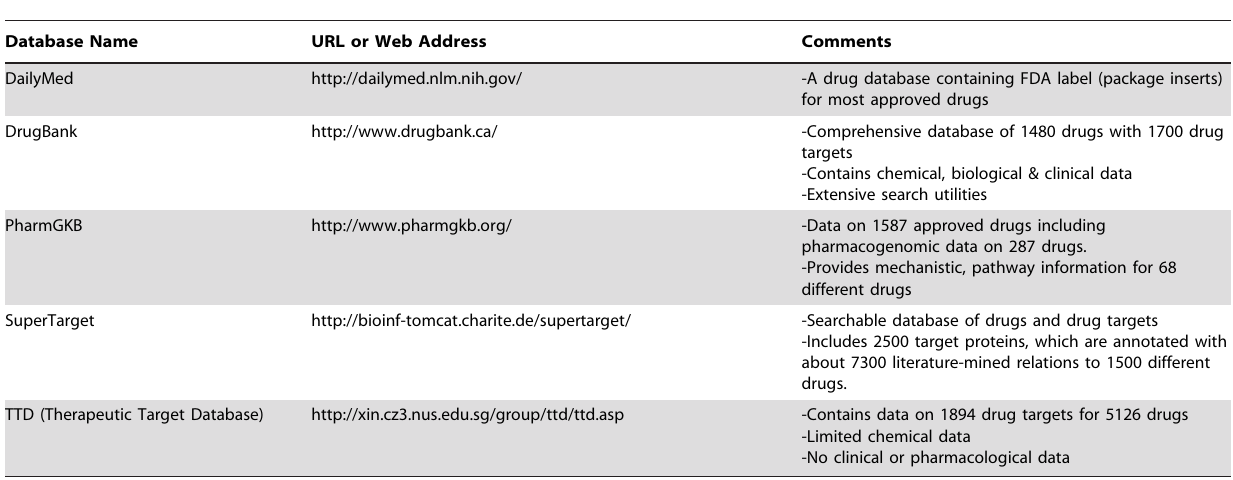
Table 3. Alphabetical List of Pharmaceutical Compound or Drug